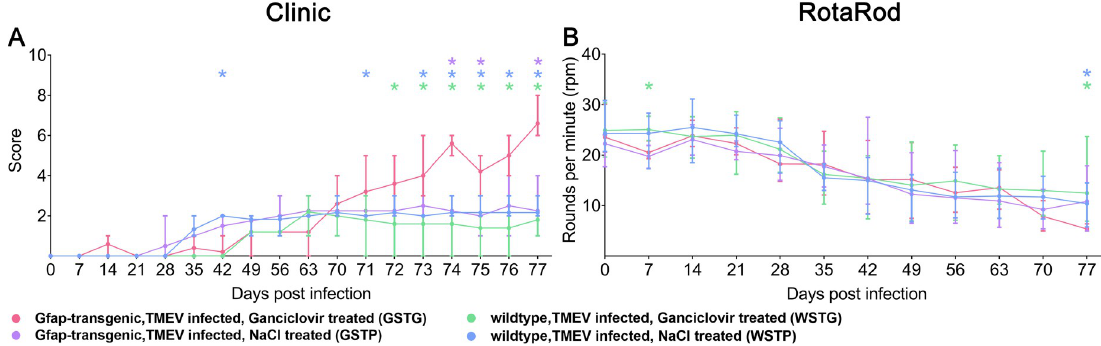
Fig 2. Clinical investigations. Astrocyte depletion between 56–77 days post infection (dpi) resulted in a deterioration of clinical signs starting at 71 dpi compared to TMEV infected, NaCl treated, GFAP-transgenic (GSTP) mice (purple asterisks), TMEV infected, ganciclovir treated wildtype (WSTG) mice (green asteriks) and TMEV infected, natrium chloride (NaCl) treated wildtype (WSTP) mice (blue asterisks, A). At 77 dpi TMEV infected, ganciclovir treated, GFAP-transgenic mice (GSTG) mice showed a significant detetioration of rotarod performance compared to the WSTG and WSTP controls (green and blue asterisks, B). Clinical and rotarod data are shown as mean and standard error of mean. Significant differences between GSTG and the respective control groups, as obtained by Kruskal–Wallis test, followed by Mann–Whitney U post hoc tests were indicated by � , p < 0.05. Part of these data were previously published